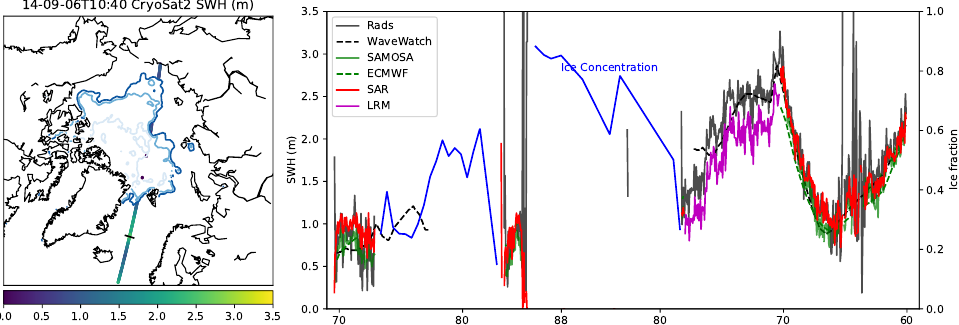
Figure 4. Significant wave height and ice concentration 6 September 2014 12:11. To the left is the map of the Arctic with NSIDC ice concentration contours of 15%, 50% and 85%. We plot our retrieved SWH from SAR and LRM modes, with the transition indicated by the black line. To the the right is the detailed SWH for the track from our new data (SAR and LRM modes), RADS (pseudo-LRM and LRM modes), SAMOSA (SAR mode) and the WaveWatch 3 and ECMWF wave models. For the regions where the orbit track intersects the sea ice cover the ice concentration is plotted. Note that the plotted latitude is symmetrical about 88 ◦ N, the northern limit of the CS2